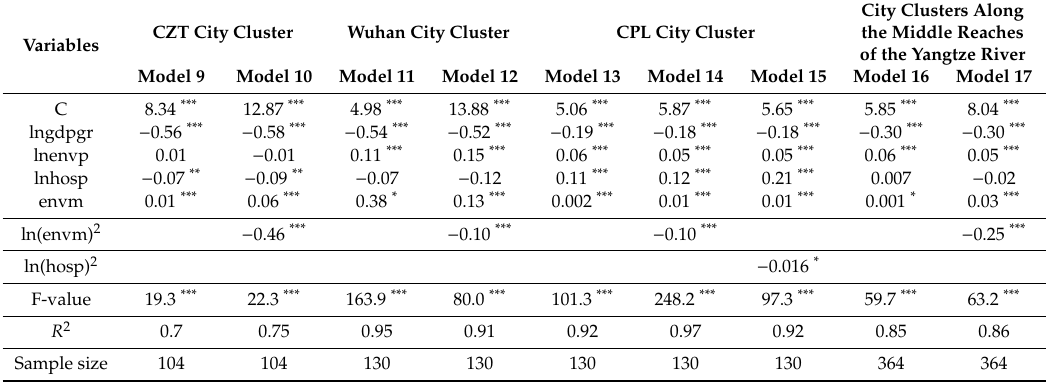
Table 4. Regression results of our model for the health of residents. ln(envm) 2 : quadratic term of the logarithm of the environmental governance; ln(hosp) 2 : quadratic term of the logarithm of the medical